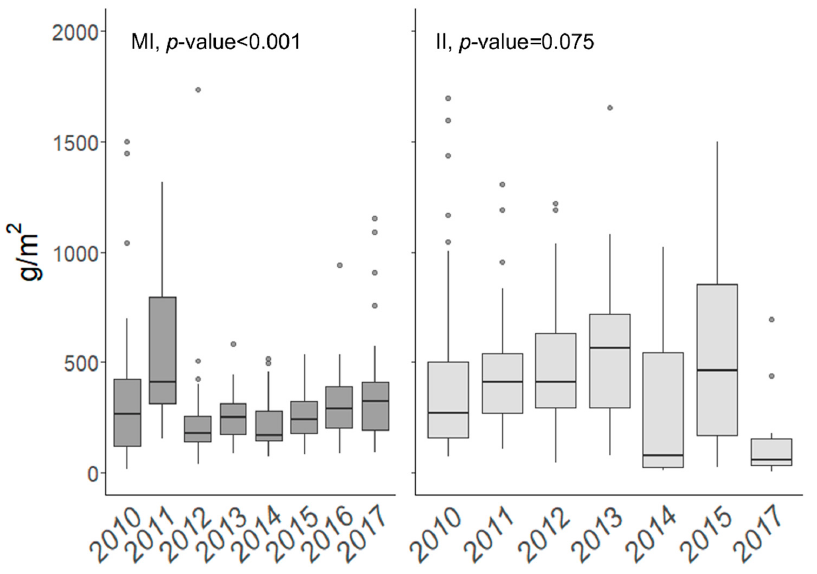
Figure 3. Comparison of annual biomass and results of one-way permutational variance analysis test. MI: Marietas Islands, II: Isabel Island.